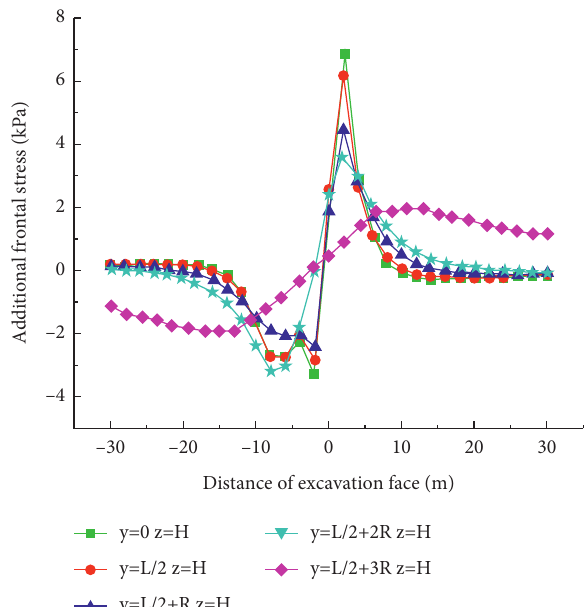
Figure 9: The distribution of the additional stress σ axis.